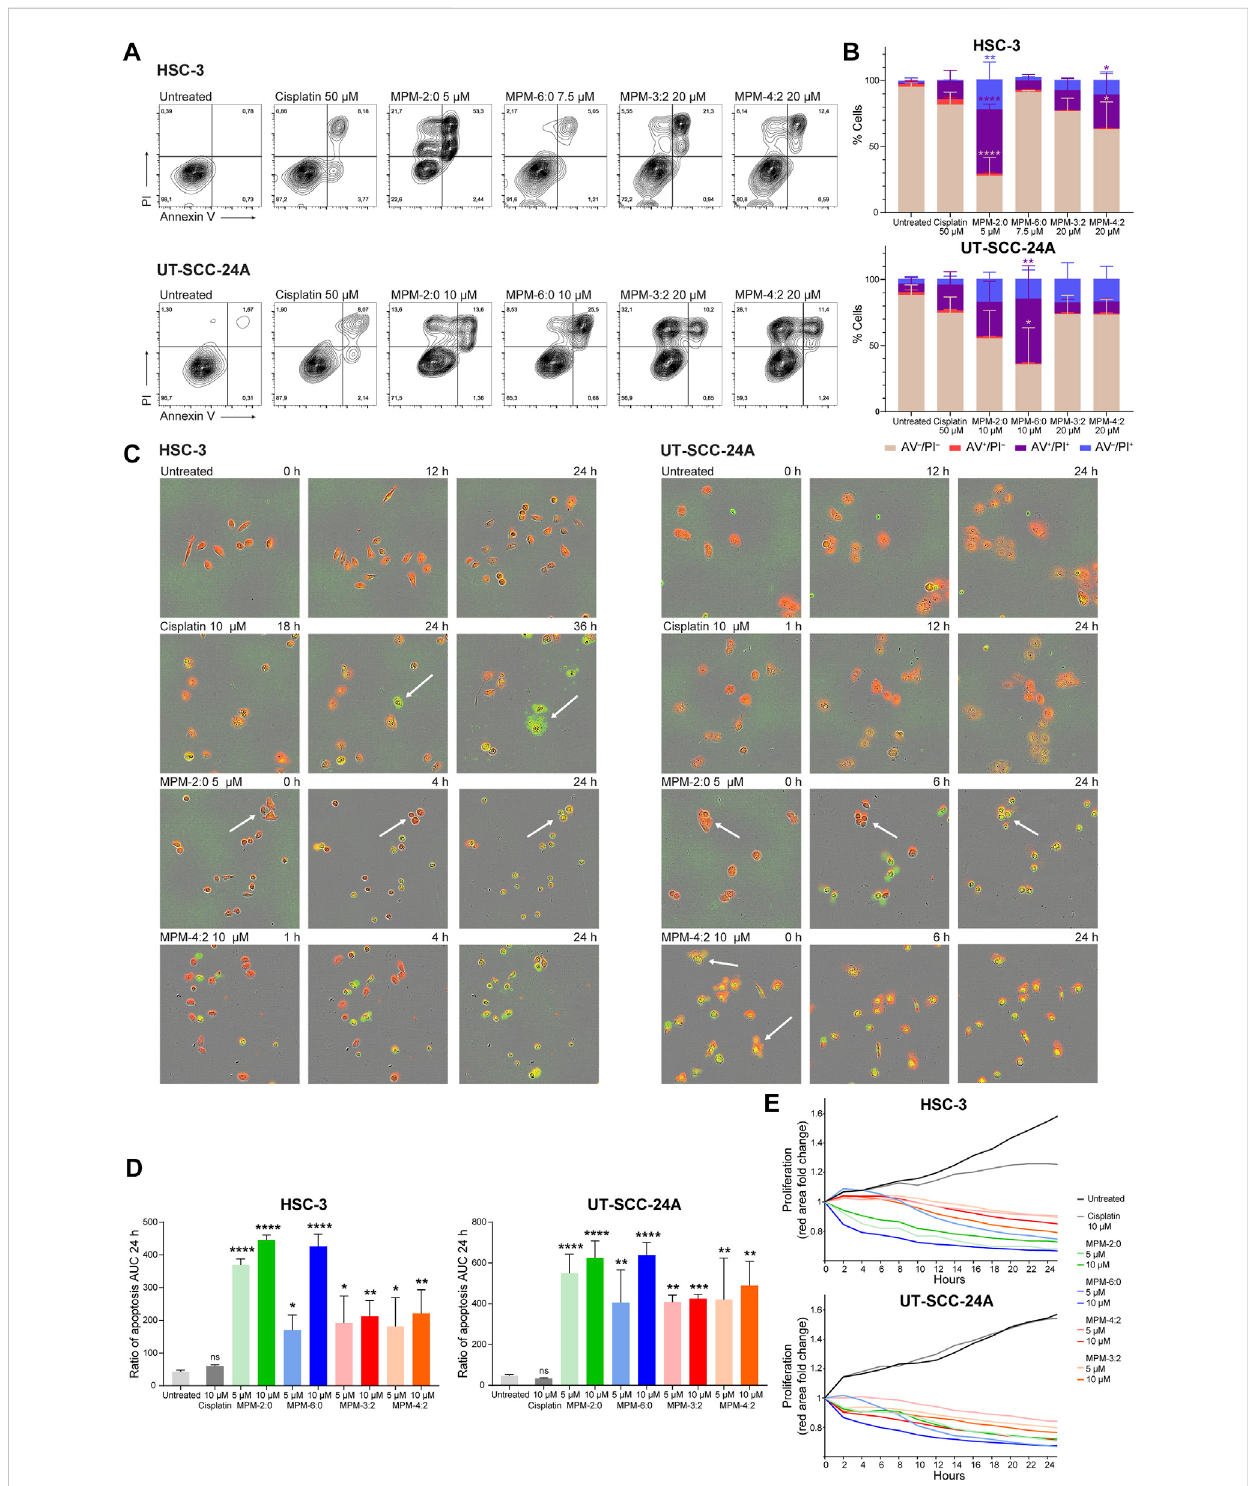
FIGURE 3 Thecellsurfaceexpressionofphosphatidylserine(determinedbystainingwithAnnexinV),whichcharacterizescellsinearlyapoptosis,wasanalyzed by fl ow cytometry in HSC-3 and UT-SCC-24A cells treated with MPMs (A) . The percentage of Annexin V – /PI – , Annexin V+/PI – , Annexin V – /PI+ and AnnexinV+/PI+cellswasdeterminedandthemeanfromthreeindependentexperimentsisshownin (B) .Statisticallysigni fi cantdifferences,ascompared totheuntreatedcellsweredeterminedbyone-wayANOVAandDunnett ’ s posthoc .AlivecellapoptosisassaywasperformedwhereHSC-3andUT- SCC-24A cells were stained red, treated with MPMs, and a dye which becomes fl uorescent (green) upon cleavage by caspase 3/7 was added. Representative images are shown in (C) , with arrows pointing to cells referenced in the text. Three independent experiments were performed, and the mean extent ofapoptosis was quanti fi ed bycalculating thearea under thecurve (AUC) for theratio of apoptosis (number of green + red objects) for 24 h (D) . The statistical differences were determined by one-way ANOVA and Dunnett ’ s post hoc . The degree of proliferation was determined by quantifying the area of red fl uorescence and is expressed as fold change relative to timepoint 0 (E)